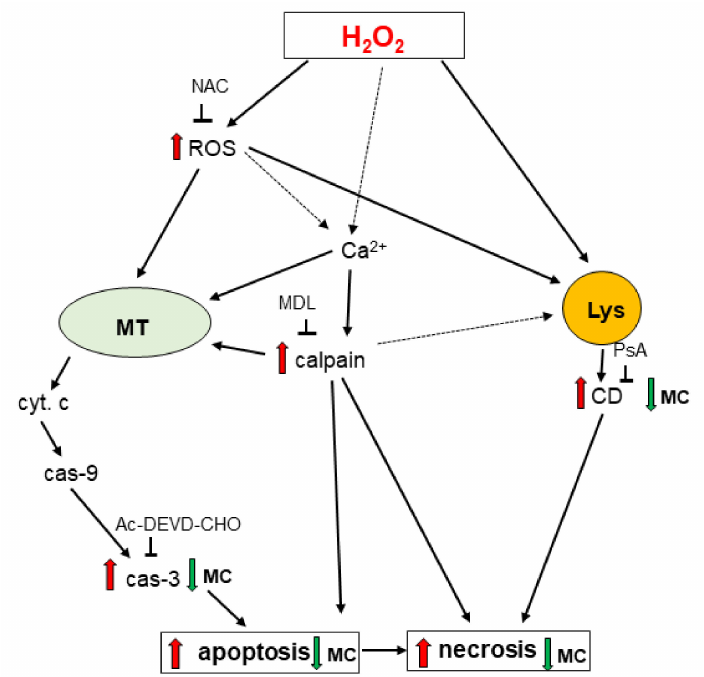
Figure 12. A schematic illustration of possible mechanisms by which methyl ca ff eate (MC) mediates neuroprotection against the H 2 O 2 -induced cell damage in undi ff erentiated (UN-) and retinoic acid (RA)-di ff erentiated SHSY5Y cells. Cathepsin D inhibition and caspase-3 inhibition are proposed as candidate mechanisms associated with neuroprotection mediated by MC in oxidative stress (H 2 O 2 )-evoked neuronal cell damage.